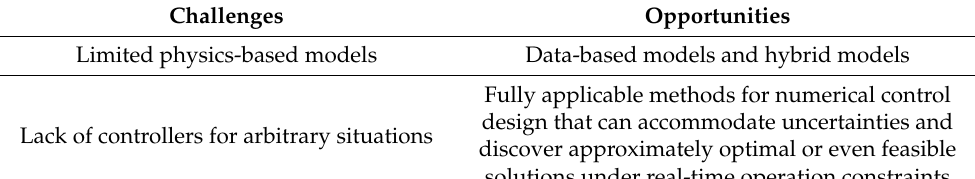
Table 5. Summary of challenges and opportunities of application of autonomous driving in EVs